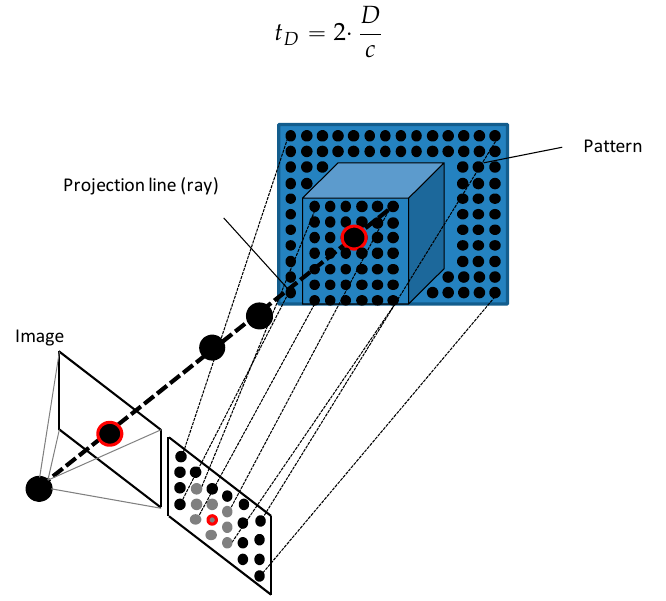
Figure 7. Projecting a pattern on the object.